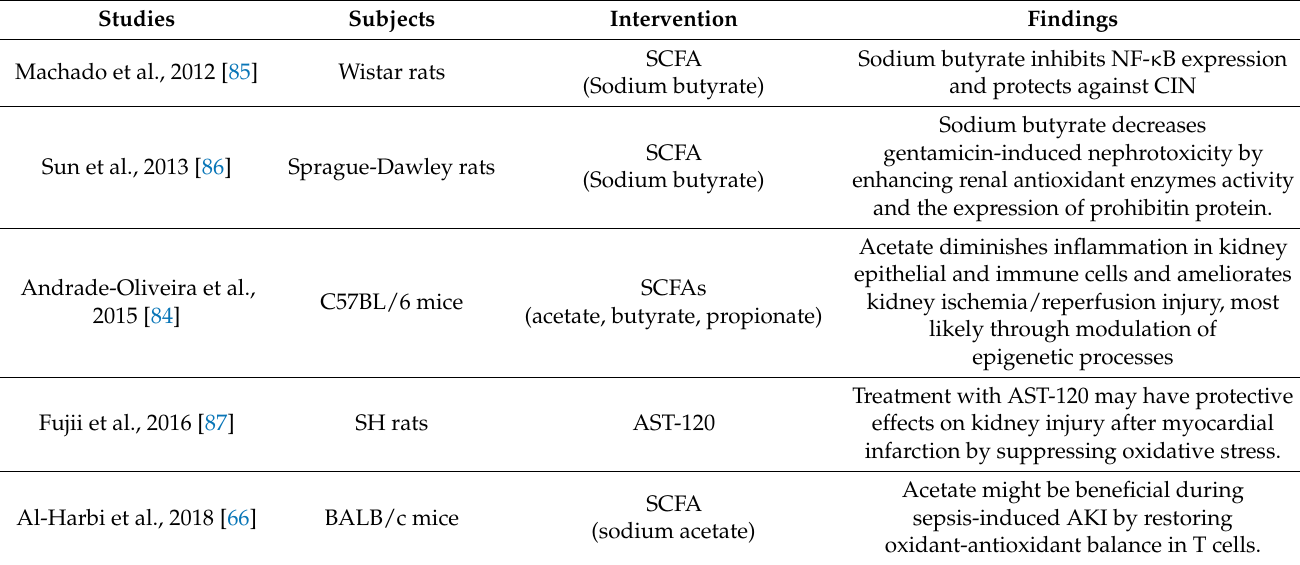
Table 3. Studies evaluating the association between AKI and